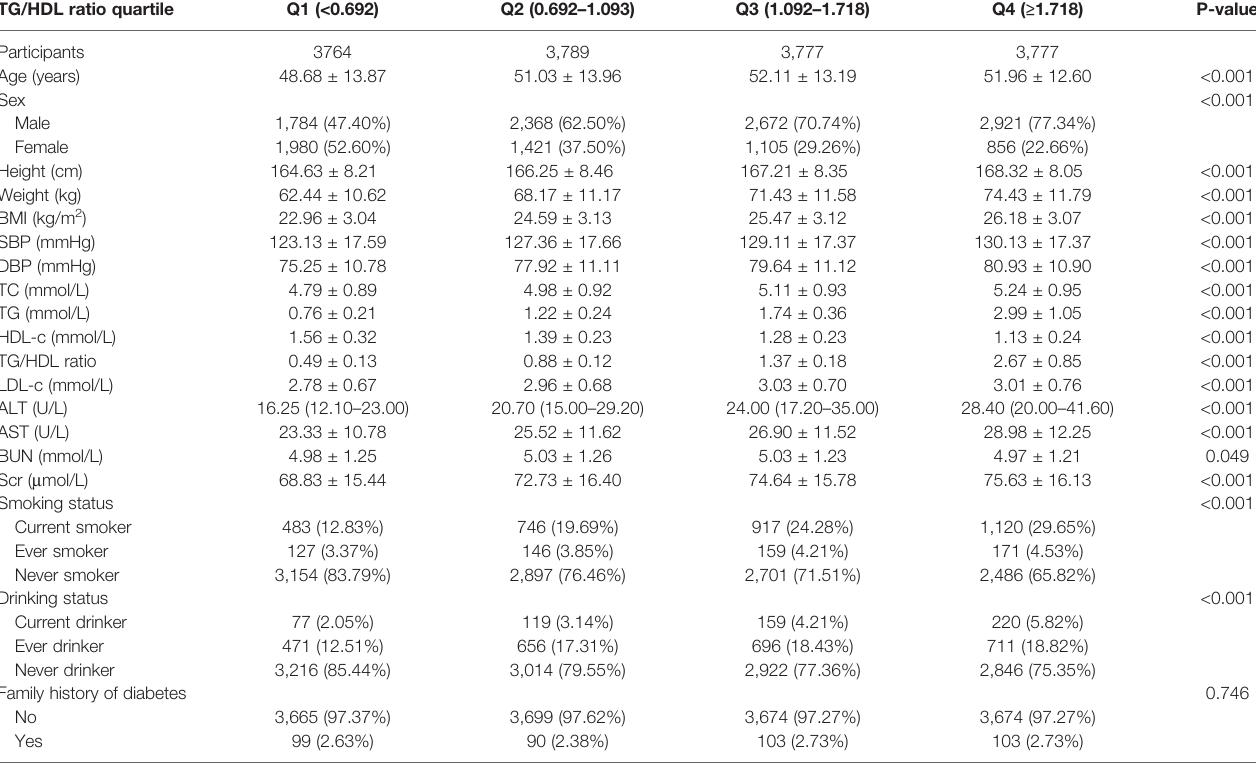
TABLE 1 | The baseline characteristics of participants. TG/HDL ratio quartile